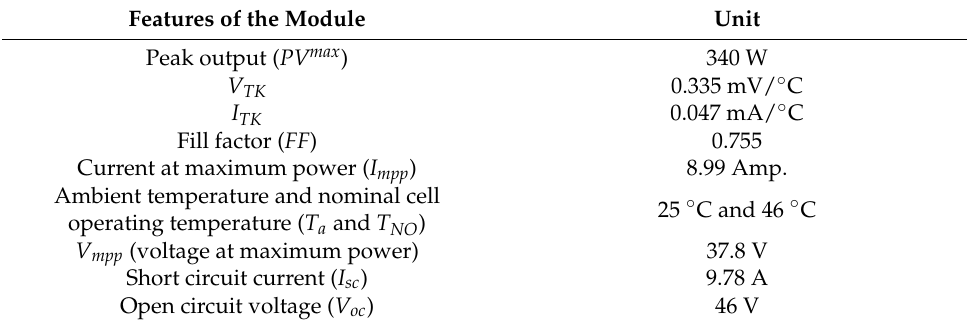
Table 3. Data on considered PV